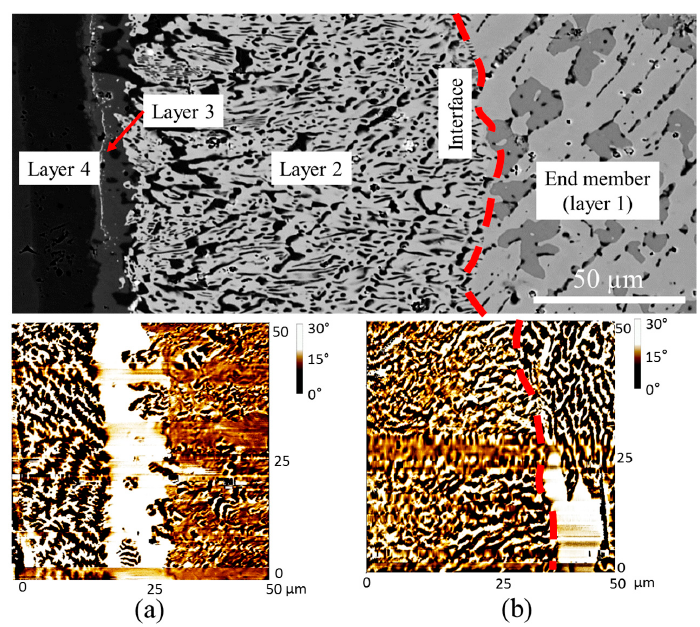
Figure 11. Microstructure ( top ) and two MFM images: ( a ) MFM test on layers 2–4 of DC4; ( b ) MFM test on the interface between layers 1 and 2 of DC4.